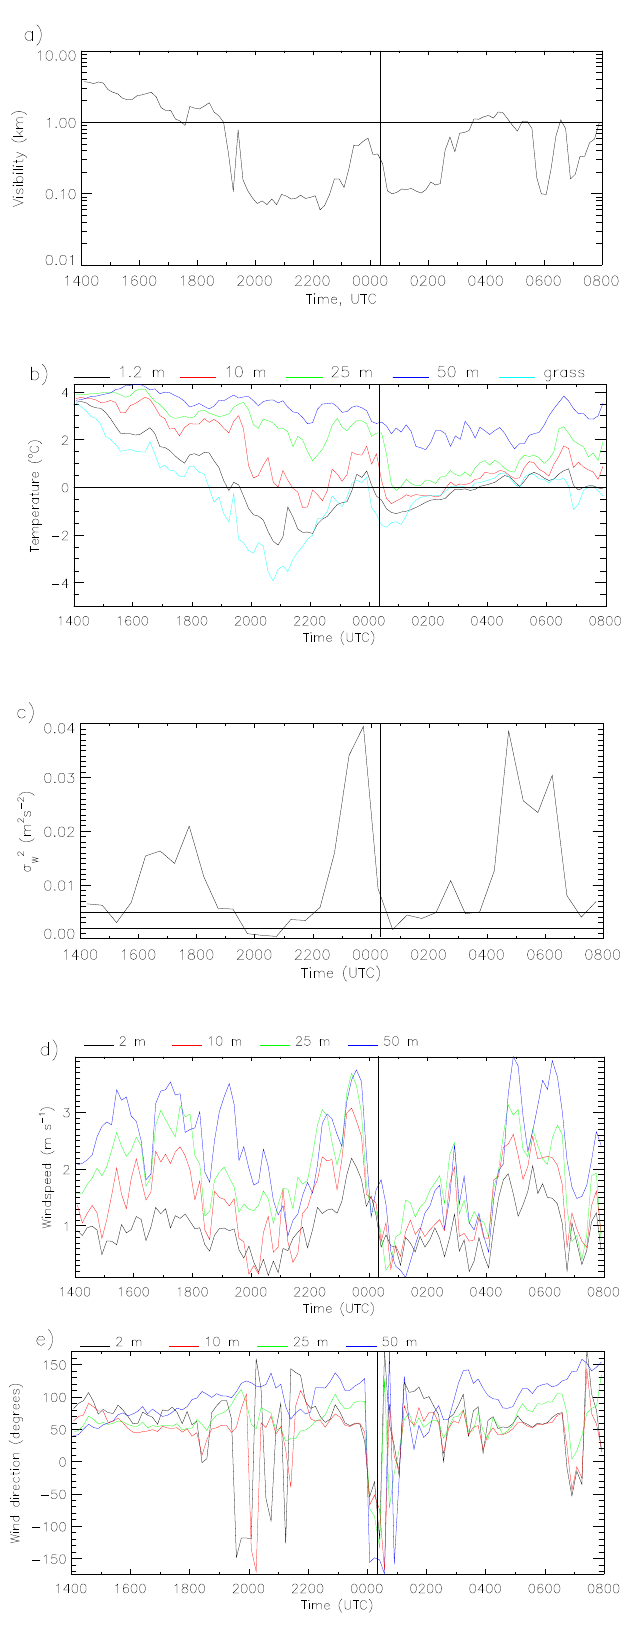
Figure 9. Meteorological data for 5–6 December 2016: ( a ) visibility, ( b ) temperature, ( c ) vertical velocity variance, ( d ) windspeed and ( e ) wind direction. The passage of the gravity current is indicated by the vertical black line.